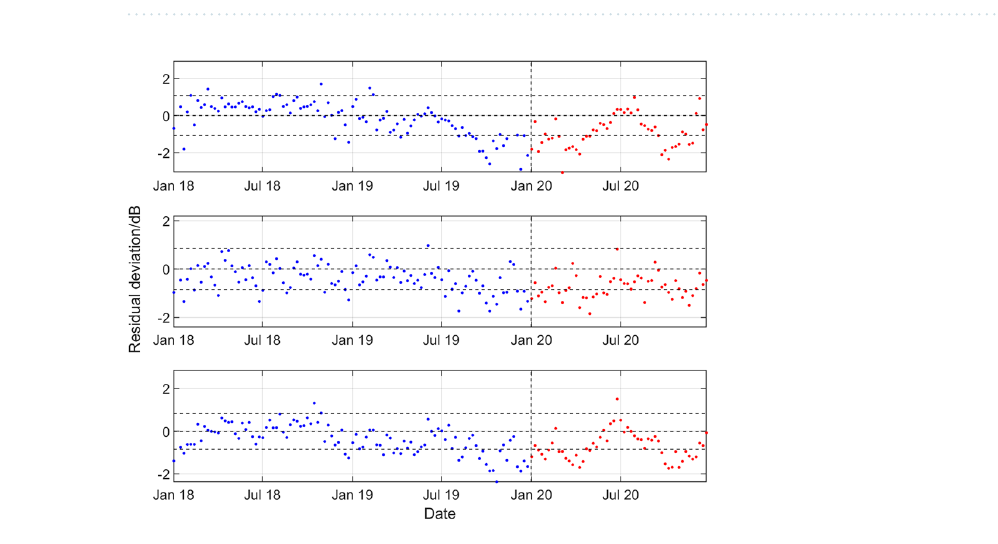
Figure 9. Results for the hydrophone H01W1 data at the CTBT Cape Leeuwin station, statistical level P 10 and (top to bottom) low, medium, and high frequency bands. For the period January 2018 to December 2019 and during 2020, deviations of the observed weekly SPSDL data from the predictable part of the signal defined by the long-term and medium-term seasonal components of the GP